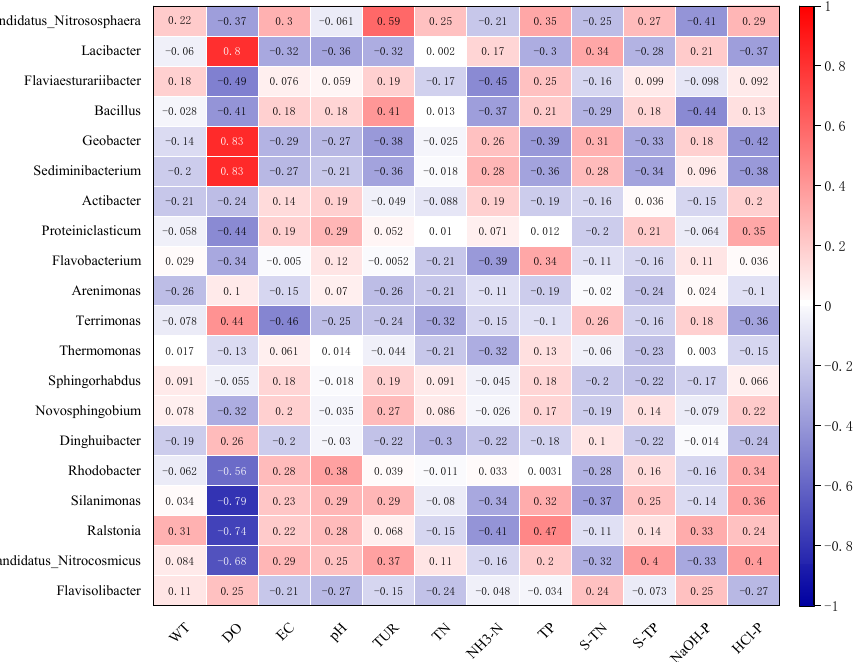
Figure 9. Correlation coefficients between environmental factors and dominant microbial genera abundance.